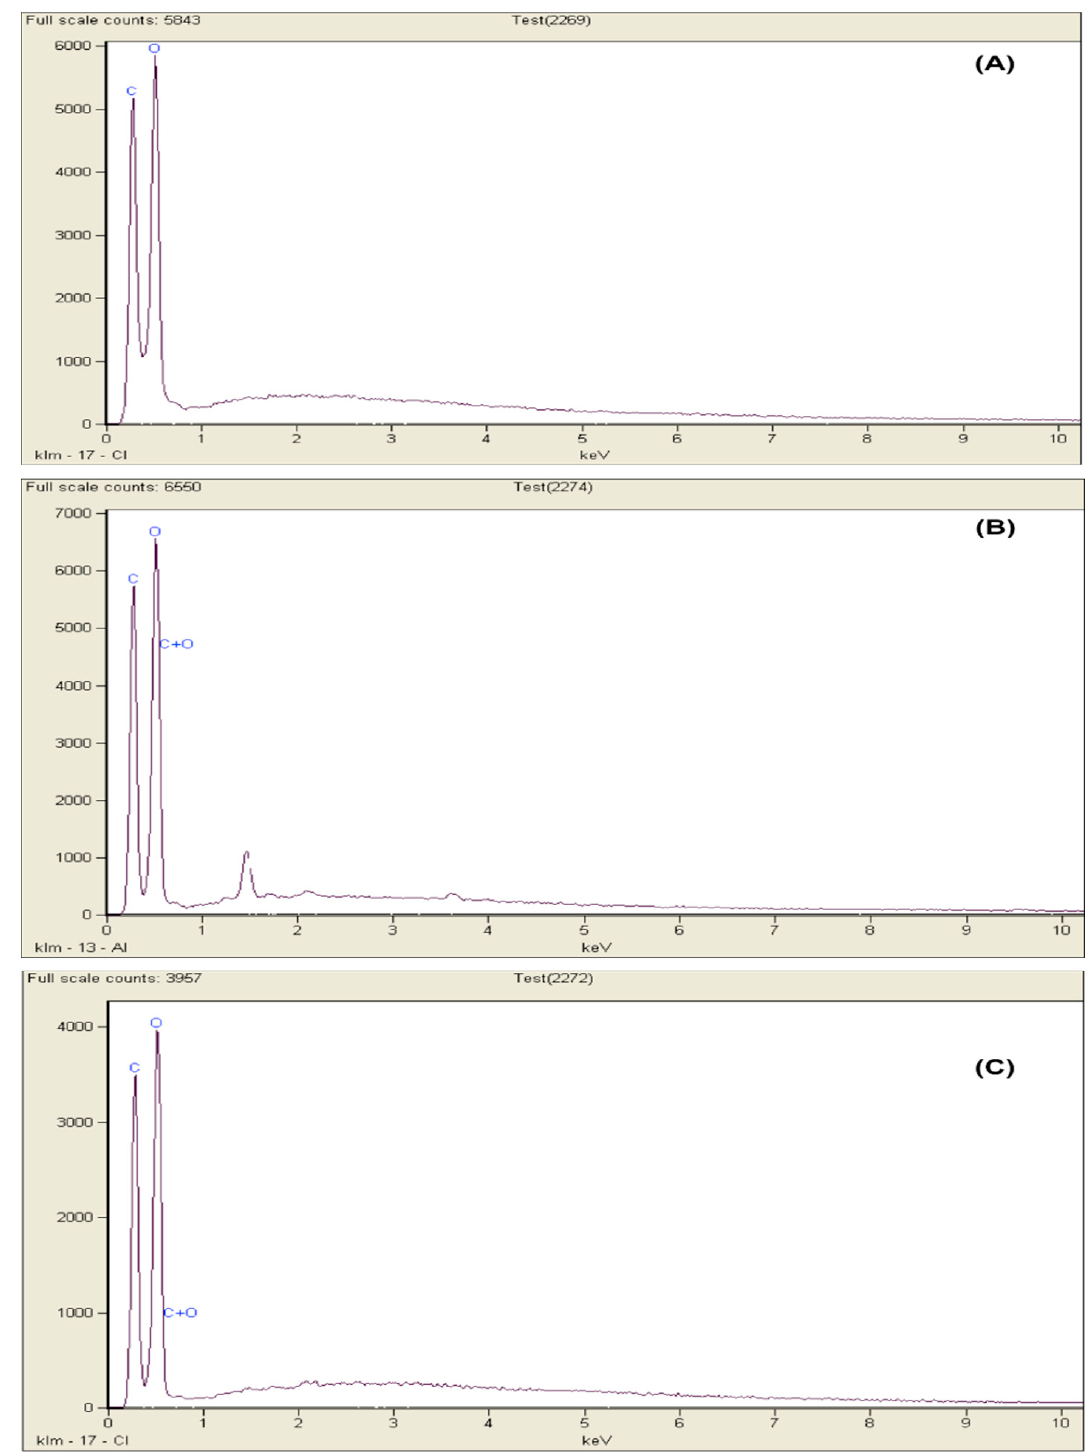
Figure 5. Energy-dispersive X-ray diffraction (EDX) spectra of ( A ) MCC, ( B ) B-Pulp and ( C ) C-Pulp isolated from bamboo fibers.